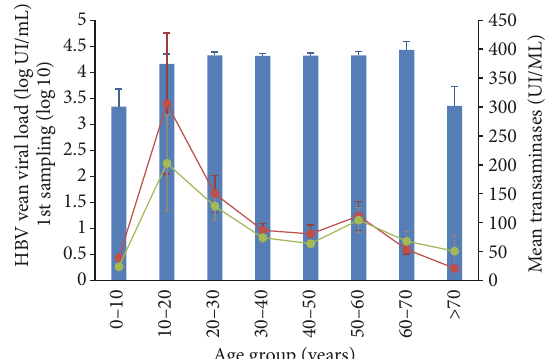
Figure 4: Mean viral load (blue bars) and aminotransferases (ALAT in red, ASAT in green) according to groups of age (ten years) at first sampling in the DQ category (only patients with VL and aminotransferases, excluding patients without